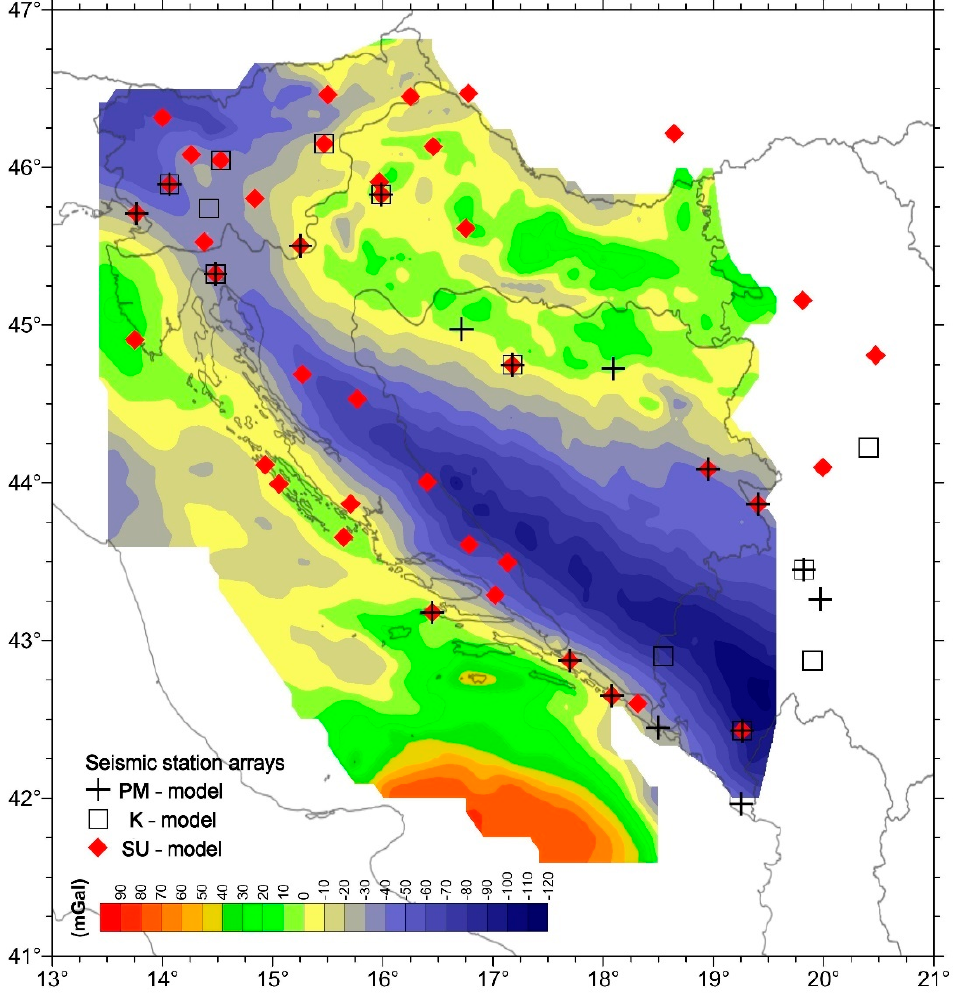
Figure 3. A generalised gravity map of the area of study extracted from [27]. Seismic station networks used in the tomographic models are superimposed and include the PM-model [6], K-model [7] and SU-model [8].